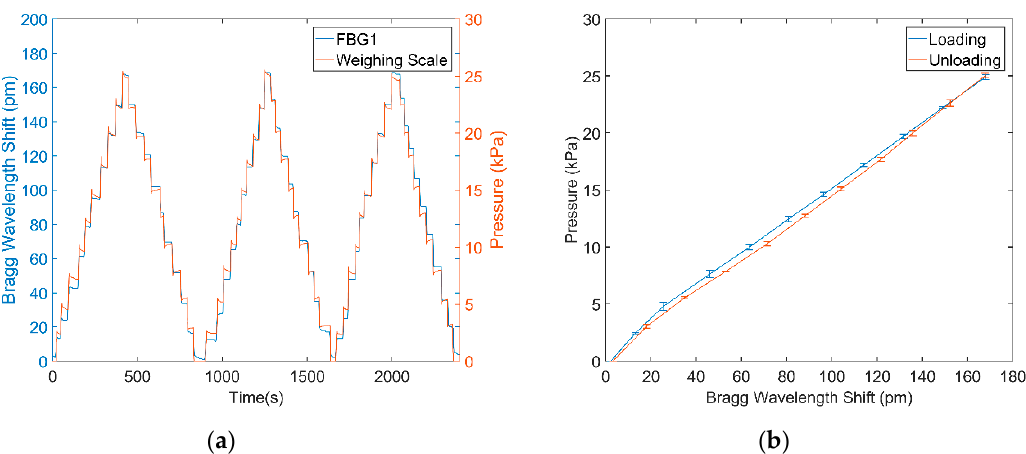
Figure 6. Step pressure increasing/decreasing experiment. ( a ) Increase the pressure step by step until 25 kPa. Then, the pressure decreased step by step to 0 kPa. This process was repeated three times. ( b ) Resulting FBG peak wavelength shift versus loaded pressures from Figure 6a demonstrating a linear relationship, repeatable results and low hysteresis.